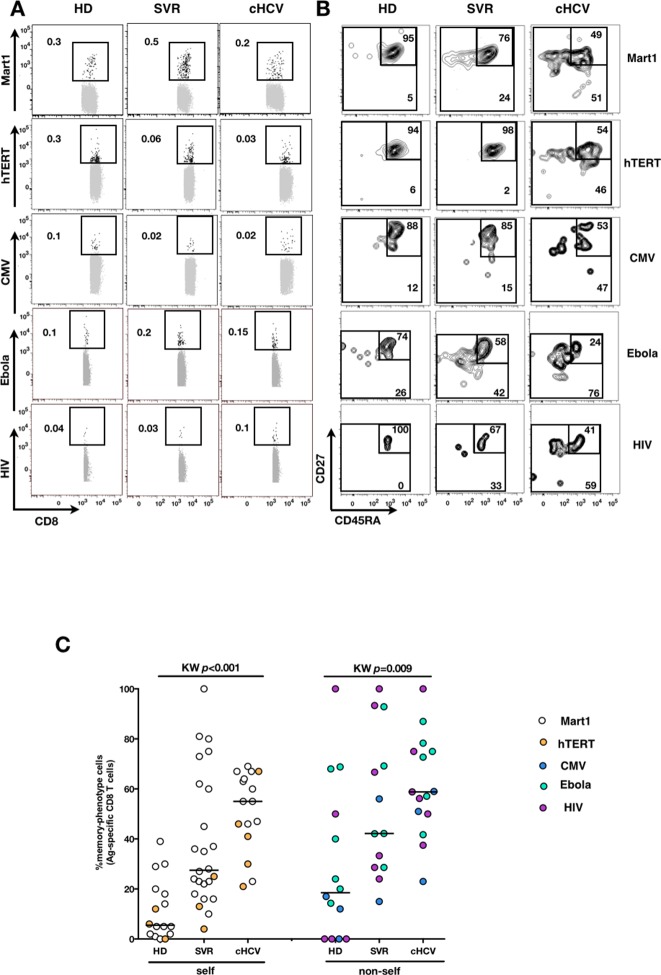
Memory-phenotype cells within self and non-self antigen-inexperienced populations.(A) Representative examples of Mart1-, hTERT-, CMV-, Ebola- and HIV- specificpopulations from HD, SVR, and cHCV patients. Enriched tetramer-specific populations are overlaid on total CD8+ T cells. (B) CD45RA/CD27 phenotype of tetramer-specific populations gated in A. (C) Percentages of memory-phenotype cells in Mart1- and hTERT- (self); CMV-, Ebola- and HIV- (non-self) specific populations from HD, SVR and cHCV patients. Further subsetting of MP inexperienced T cells into CD45/CD27-based T cell differentiation phenotype is provided in Figure 3—figure supplement 1.